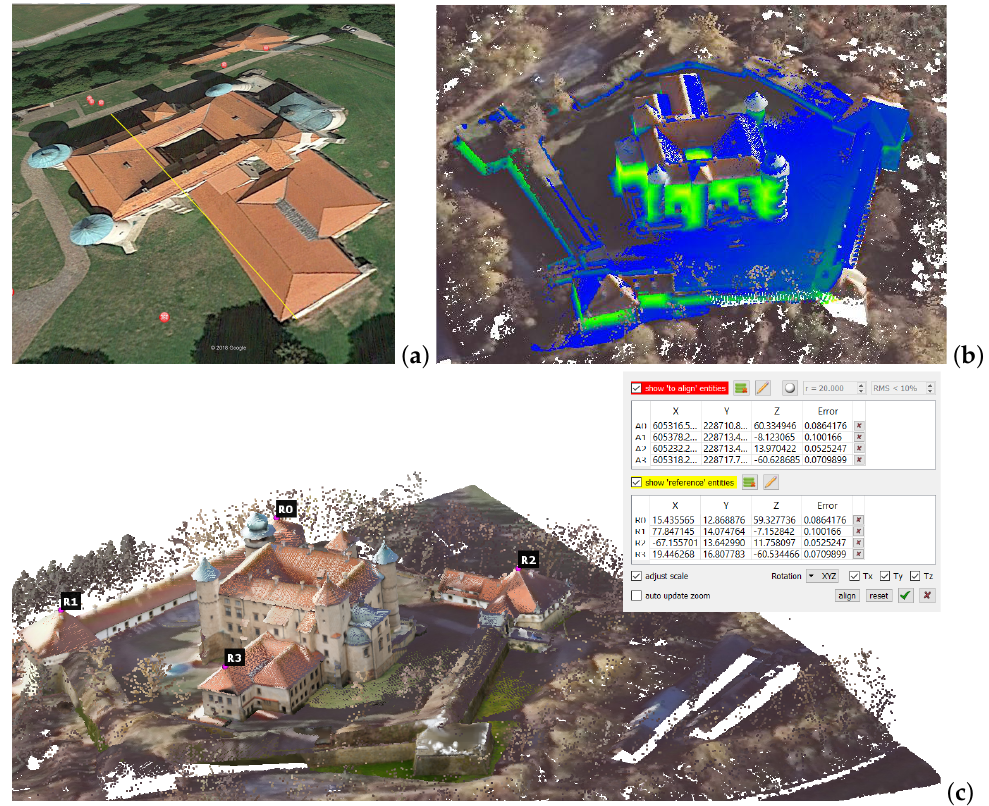
Figure 15. Scaling up the model ( a ); estimation of the error of fitting the reconstructed model to the LAS ISOK point cloud using the RMS-error method ( b ); fitting the reconstructed model to the LAS ISOK point cloud using the vertex matrix multiplication method. The numbers indicate where pairs of points are indicated ( c